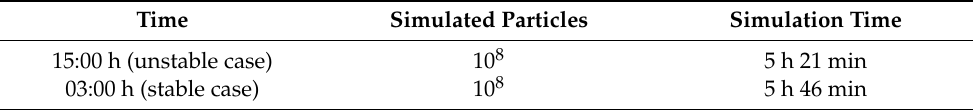
Figure 1. Diurnal boundary conditions for potential air temperature (solid line) and relative hu- midity (dashed line). Table 1. Simulated particles and simulation duration per examined scenario. Table 1. Simulated particles and simulation duration per examined scenario. Time Time